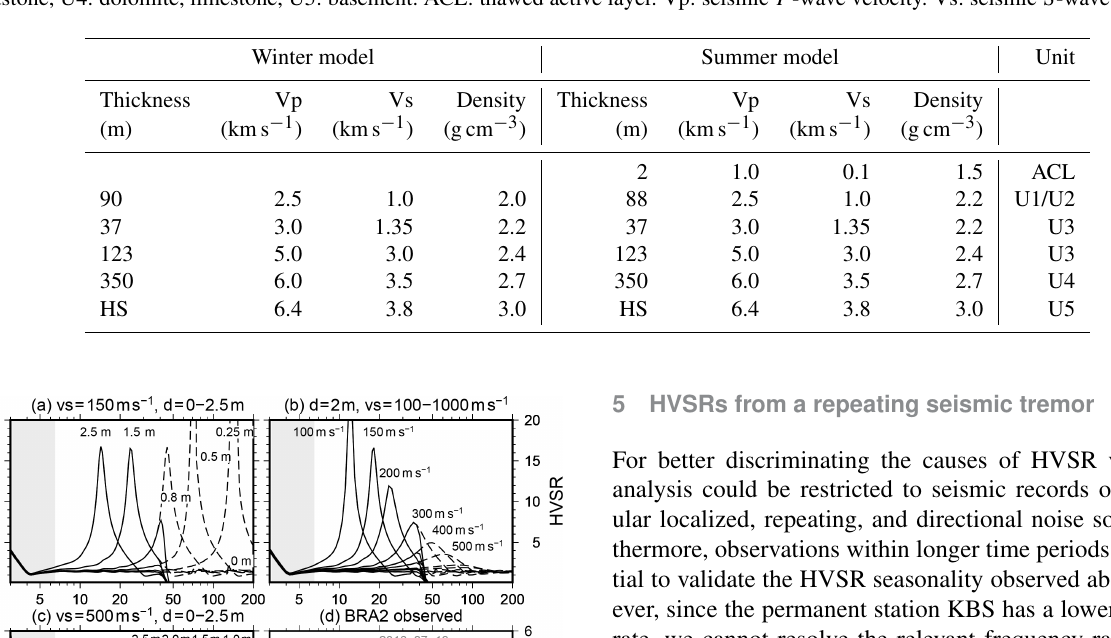
Table 1. Reference seismic velocity models for the study site based on geological site information available (Haldorsen and Heim, 1999) and adjusted to explain observed Rayleigh wave ellipticities and phase velocities. Winter model: frozen active permafrost layer. Summer model: unfrozen active layer. HS: half space. Geological units in Haldorsen and Heim (1999): U1: sandstone, U2: shale, U3: chert, glauconitic sandstone, U4: dolomite, limestone, U5: basement. ACL: thawed active layer. Vp: seismic P -wave velocity. Vs: seismic S -wave velocity.